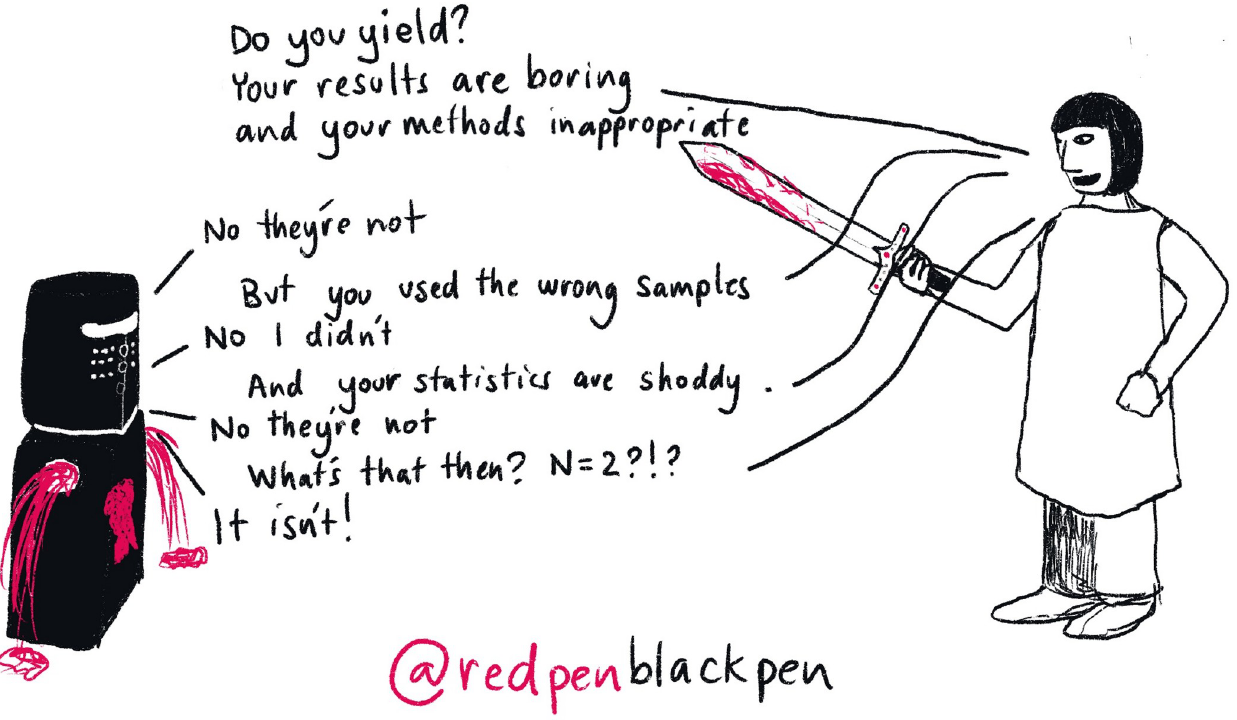
Fig 7. Bounce back from failure. Persistence and perseverance are two qualities that are vital to becoming and being a PI. You should stand up for and argue your point but remain aware that you could be wrong.